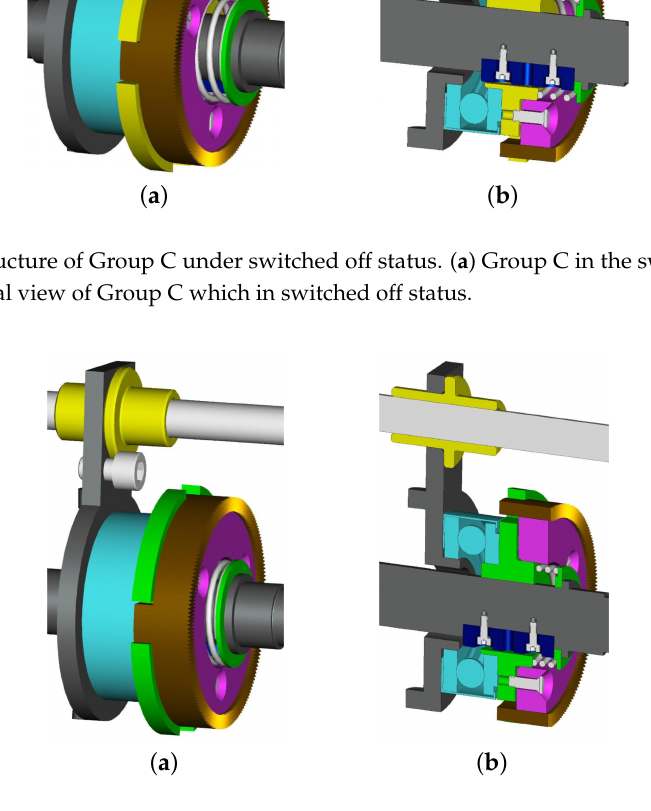
Figure 3. The structure of the PSU in “switched on” status. The spring (Part 22) is compressed. ( a ) Group C in switched off status. ( b ) Cross-sectional view of Group C in switched off